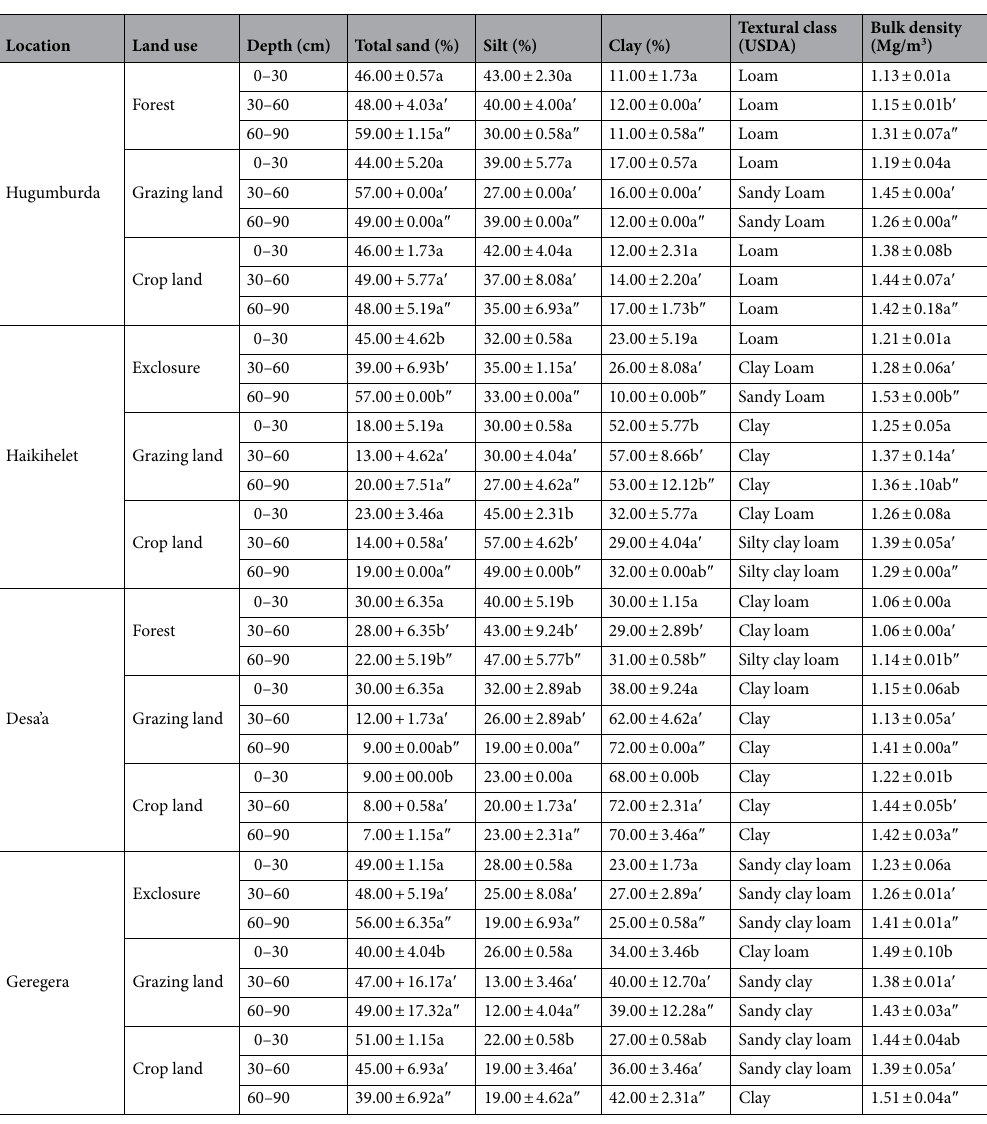
Table 5. Soil physical properties under different land uses and soil depths in the study locations. ± Mean followed by standard errors. Letters after the standard errors indicate significant differences ( p < 0.05)